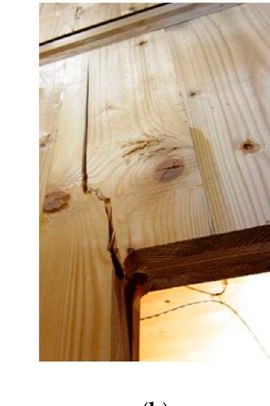
Figure 3. Failure modes of a seven-storey CLT building in shake table testing: ( a ) out-of-plane bend- ing of hold-down; ( b ) pulling-out of nails in angle brackets; ( c ) embedment of a connector [16].